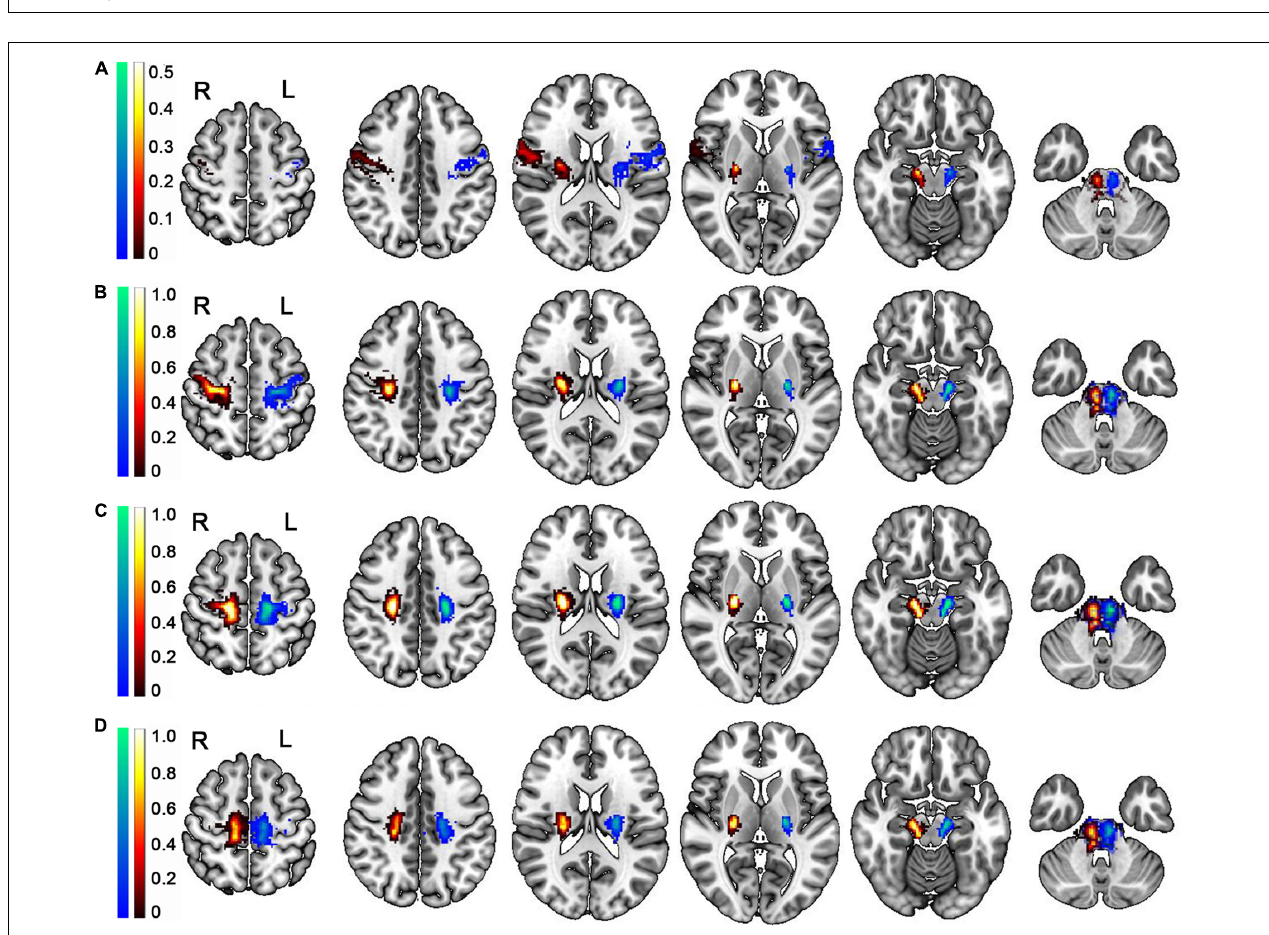
FIGURE 7 | Group-wise probabilistic maps of the PT branches tracked based on the GQI diffusion model. (A) The group-wise probabilistic map of PT ranial . (B) The group-wise probabilistic map of PT Ulimb . (C) The group-wise probabilistic map of PT trunk . (D) The group-wise probabilistic map of PT Llimb . L, left; R, right; PT, pyramid tract; PT cranial , the head and face and tongue and larynx region; PT Ulimb , the hand region; PT trunk , the body region; PT Llimb , the foot region. The color bar represents the probability across participants; the warm color represents the probability of right PT branches, and the cold color represents the probability of left PT